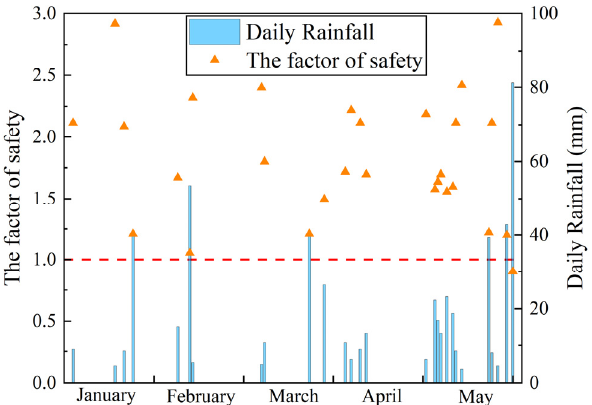
Figure 13. The stability calculation results of the slope at Pizzo d’Alvano massif.